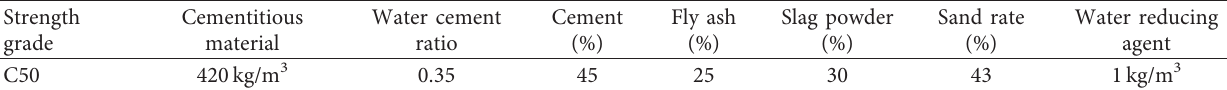
Figure 2: Schematic diagram of real-time high-temperature true triaxial loading system. (a) Real-time high-temperature true triaxial test system. (b) Interior layout drawing of real-time high-temperature true triaxial test system. (c) Schematic of the subsystem for the maximum and intermediate principal stress loading. (d) Schematic of the subsystem for the major principal stress loading. Table 1: Mixture proportions of the concrete used in the